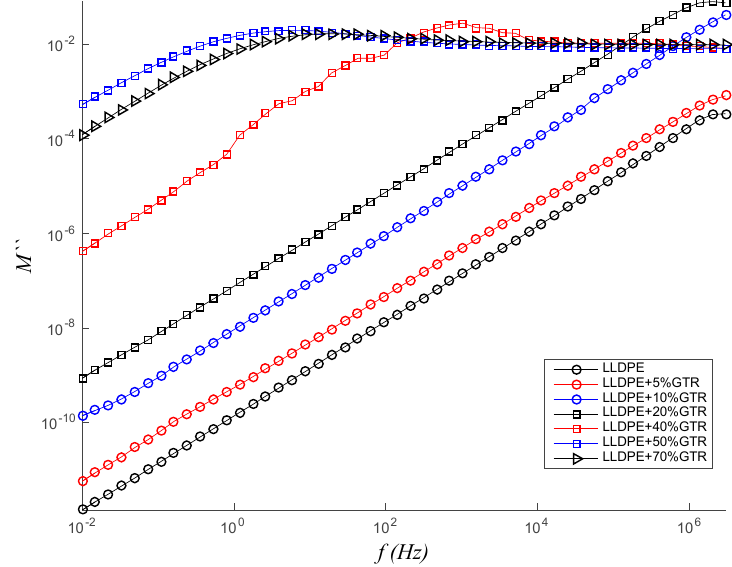
Figure 8: Imaginary electrical module (M’’) of the LLDPE/GTR at 120 °C depending on the frequency, Figure 8. Imaginary electrical module (M”) of the LLDPE / GTR at 120 ◦ C depending on the frequency, which ranges from 10 − 2 to 3 × 10 6 which ranges from 10 − 2 to 3·× 10 6 Hz.